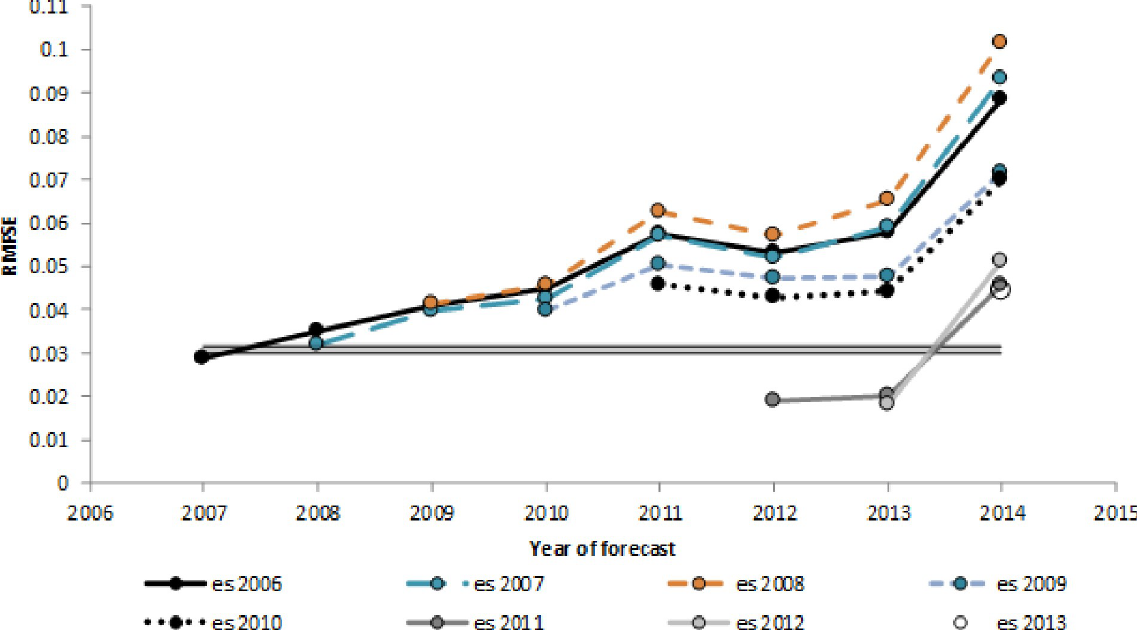
Fig 3. Multi-step-ahead forecast RMSE, 2007 to 2014. The gray bar indicates the range of in-sample regression standard errors. Each line indicates the multi-step ahead forecasts using model estimates in a given year. For example, the thick black line, ‘es 2006’ shows the forecasts for years 2007 through 2014 using the model estimated using the sample period 1992 to 2006. RMSFE: Root Mean Square Forecast Error.